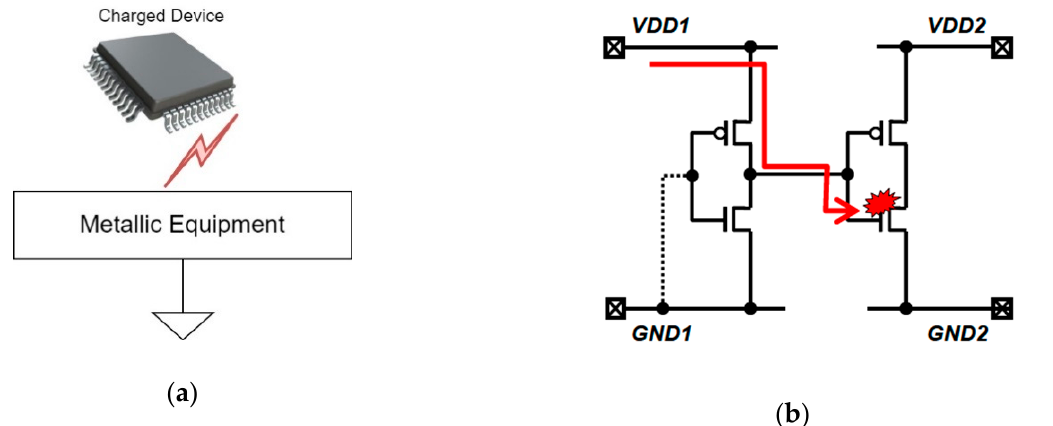
Figure 1. Charge device model (CDM) occurrence: ( a ) the pin touches a grounded metallic surface; ( b ) CDM electrostatic discharge (ESD) current path in an input buffer.